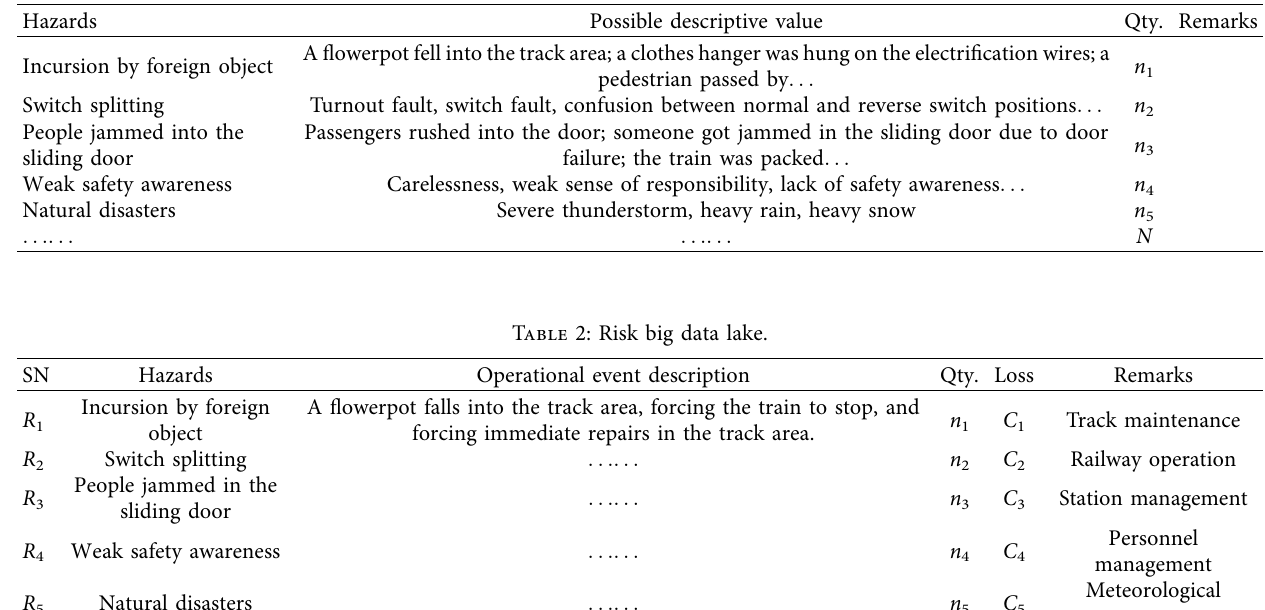
Table 1: Hazard cloud merging and